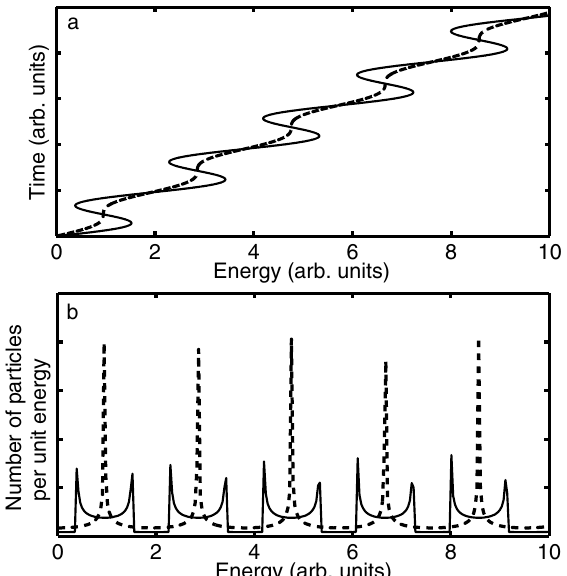
FIG. 3. Sketch of the beam longitudinal phase space (a) and its projections on the energy axis, or CBE spectrum (b). Intrinsic energy spread is neglected. Two beams are shown, one with a larger (solid) and a second with a smaller (dashed) energy modulation amplitude. The beam with a larger ampli- tude represents the overmodulated case, i.e., energy along the bunch is not a monotonic function of time. The energy spec- trum of the beam with a smaller modulation amplitude looks significantly more ‘‘spiky.’’